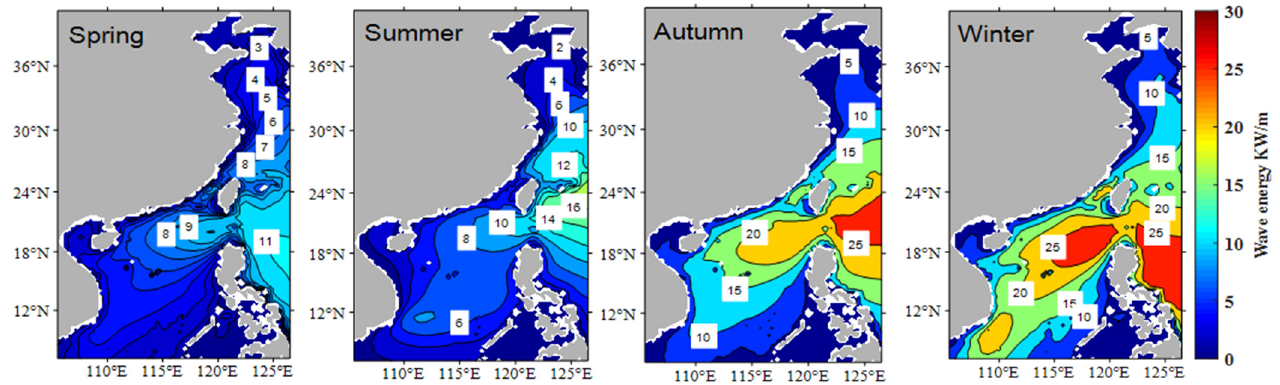
Figure 3. Seasonal mean P w.